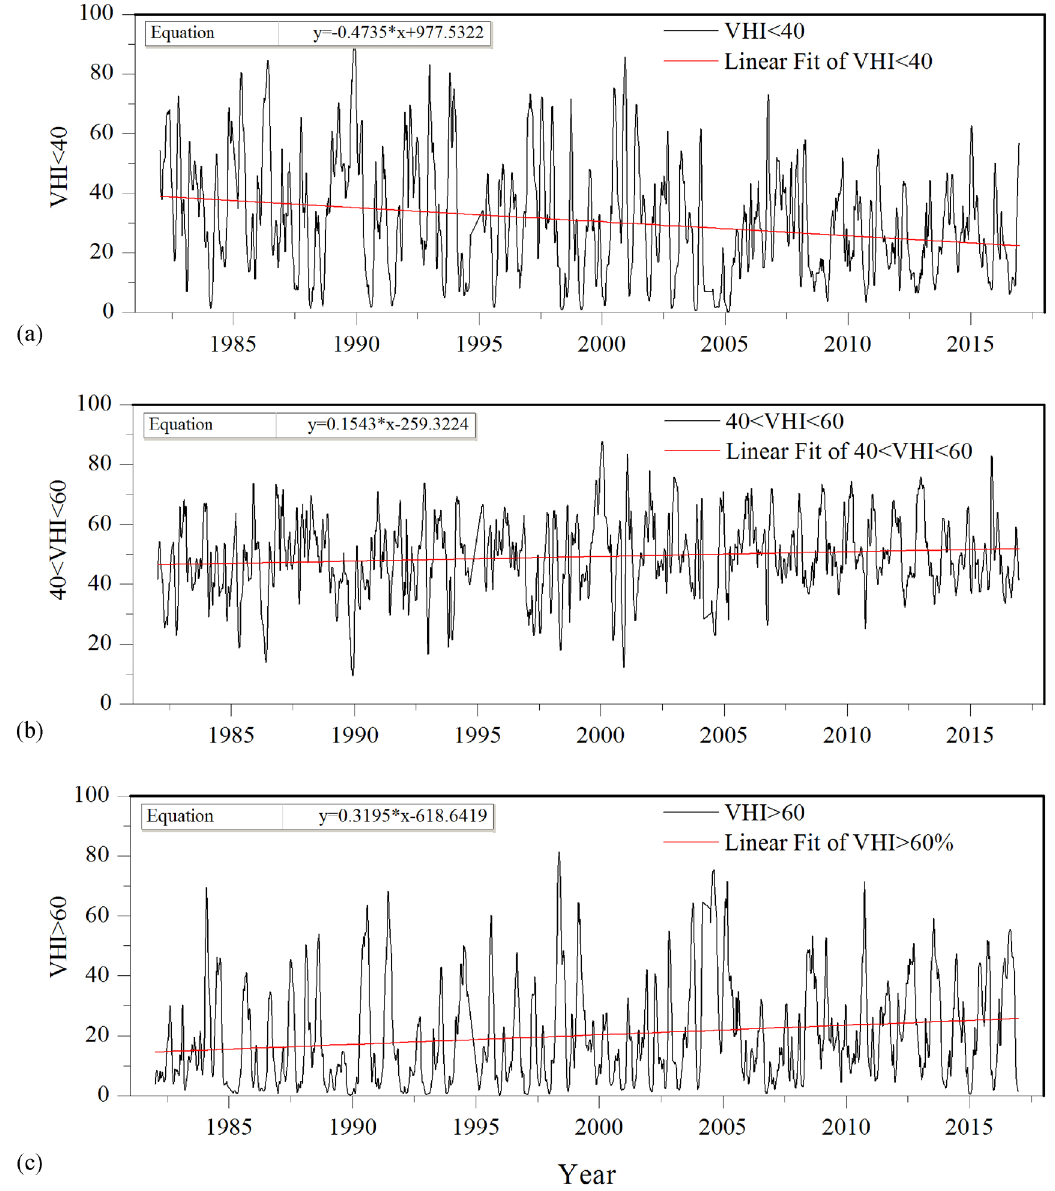
( b ) 40 < VHI < 60 indicates vegetation with normal condition; ( c ) VHI > 60 indicates vegetation with favorable